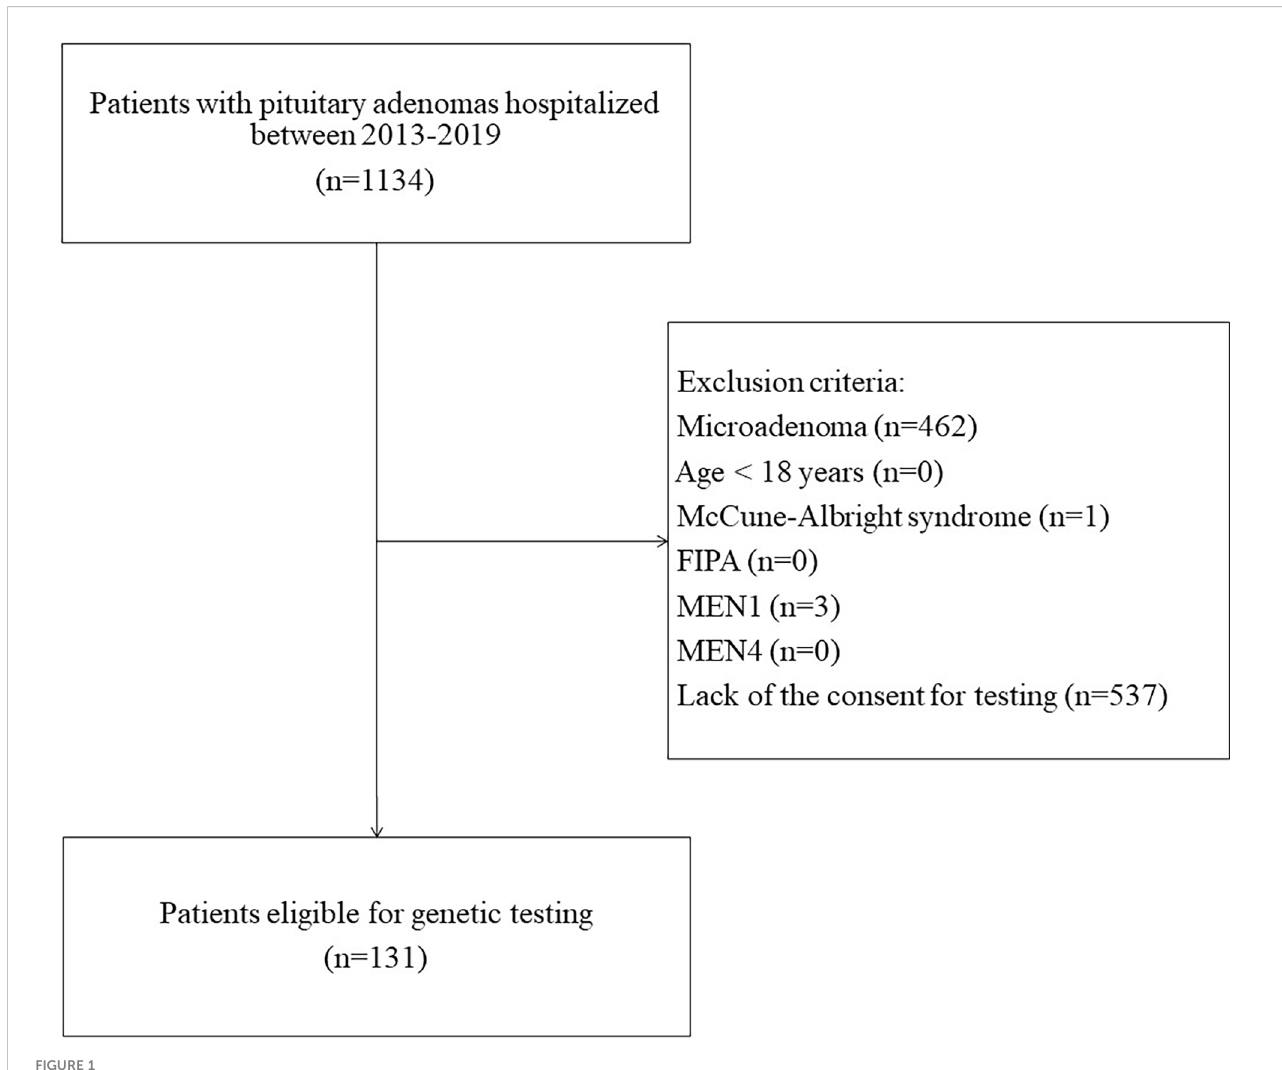
FIGURE 1 Flow chart of the patients ’